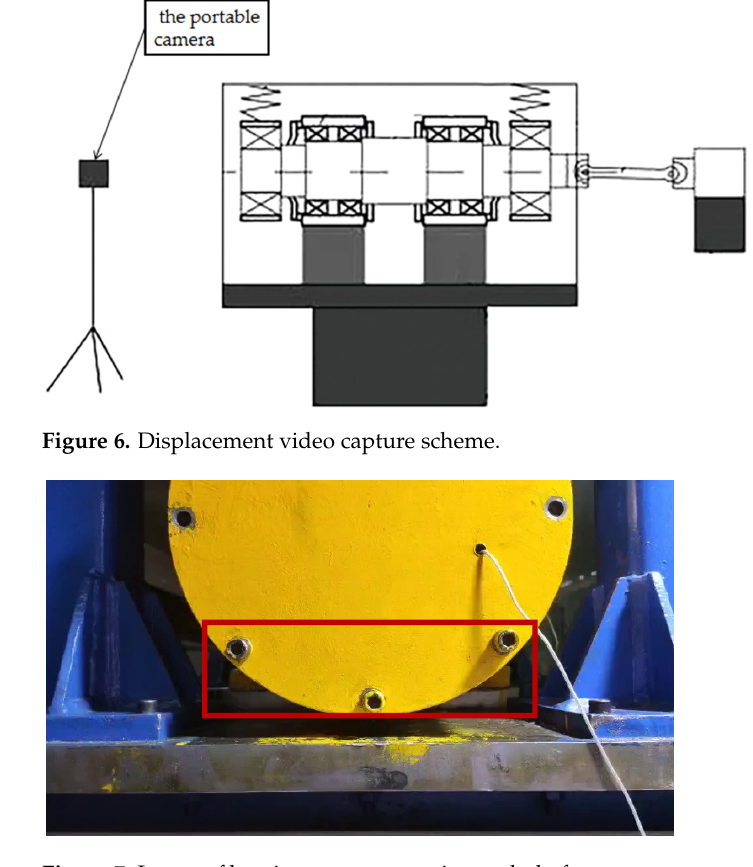
Figure 7. Image of bearing system experimental platform.